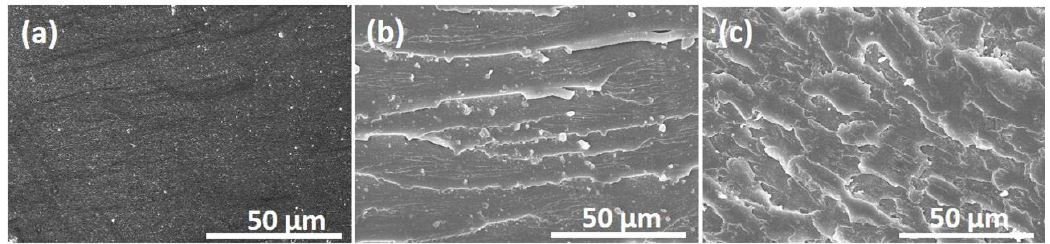
Figure 5. SEM fractographs of ( a ) neat epoxy, ( b ) CaCO 3 nanocubes/epoxy composites with 1.5 wt.% CaCO 3 nanocubes (EP-cube-1.5), and ( c ) CaCO 3 nanorods/epoxy composites with 1.5 wt.% CaCO 3 nanorod (EP-rod-1.5).